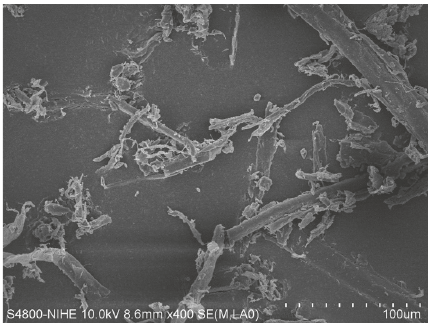
Figure 1: FESEM image of original WF.